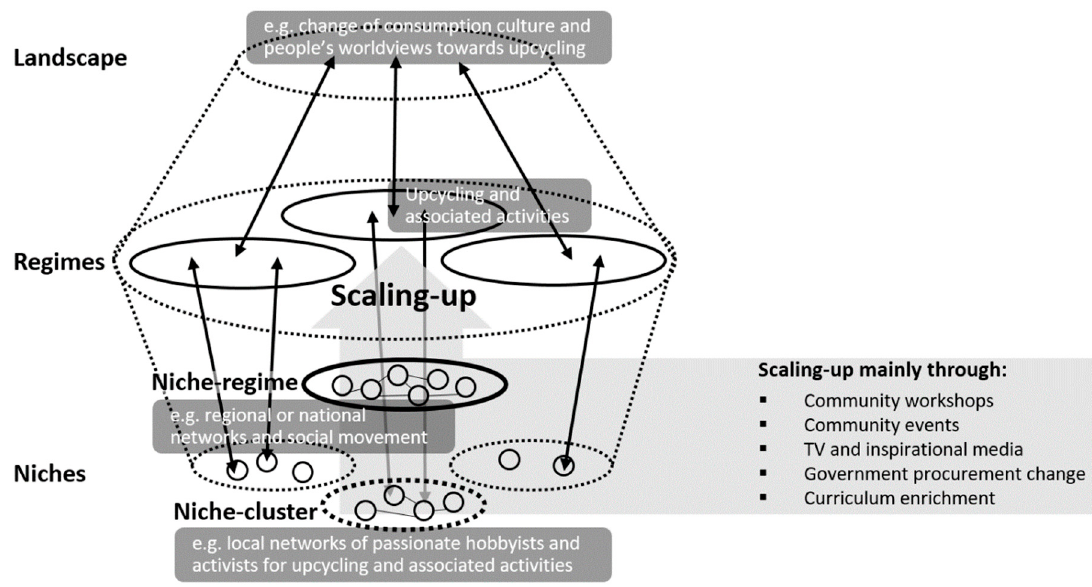
Figure 7. Scaling up of upcycling in consumption domain [15].